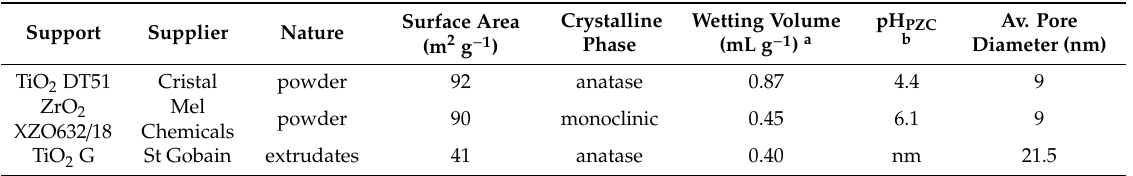
Table 2. Characteristics of commercial